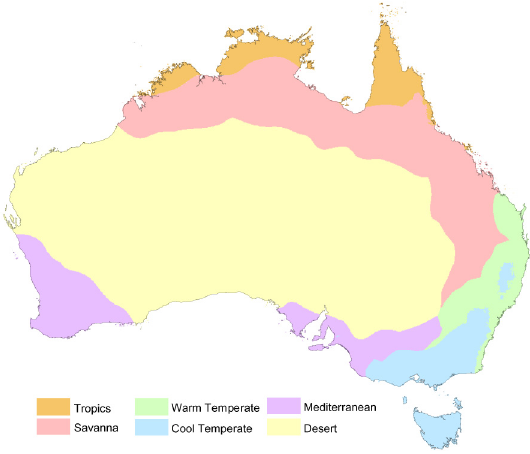
Fig. 3. Bioclimatic classification for use in regionalisation of re- sults.